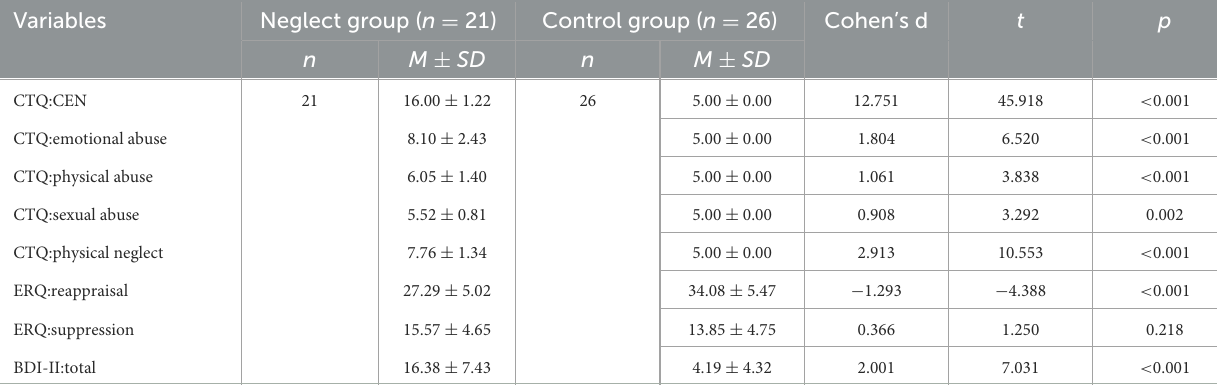
TABLE 1 Differences in questionnaire data between the two groups ( n =